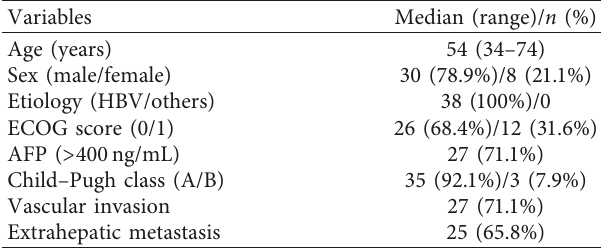
Table 1: Patient characteristics ( n � 38).